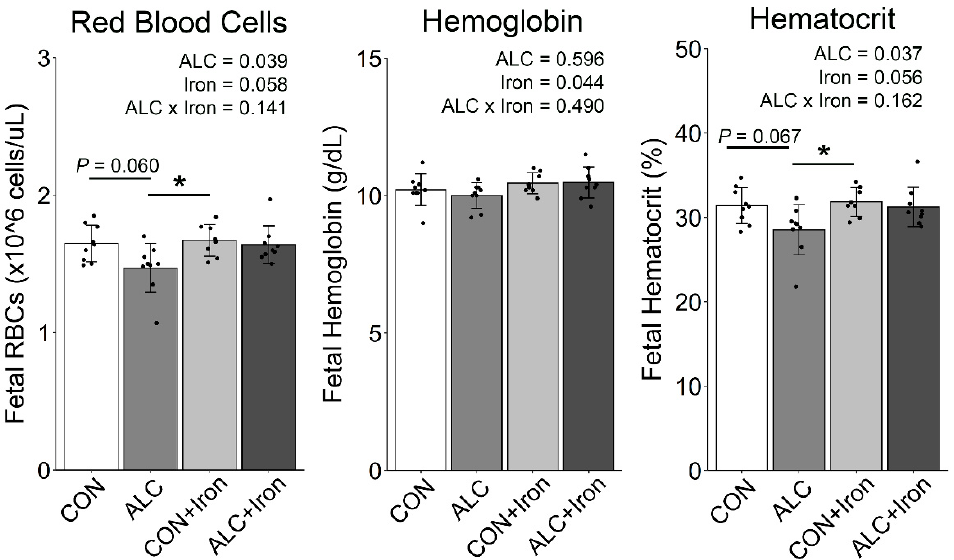
Figure 3. Alcohol exposure reduced fetal RBCs and hematocrit, and were normalized by iron supplementation. n = 8–9 litters per group (blood pooled across the litter). Each data point (black dot) represents values for individual litter, and bars show the group means ± SD. * p < 0.05. ALC, alcohol exposed; CON, control; RBCs, red blood cell count. Table 5. Alcohol exposure caused fetal anemia which iron supplementation resolved.